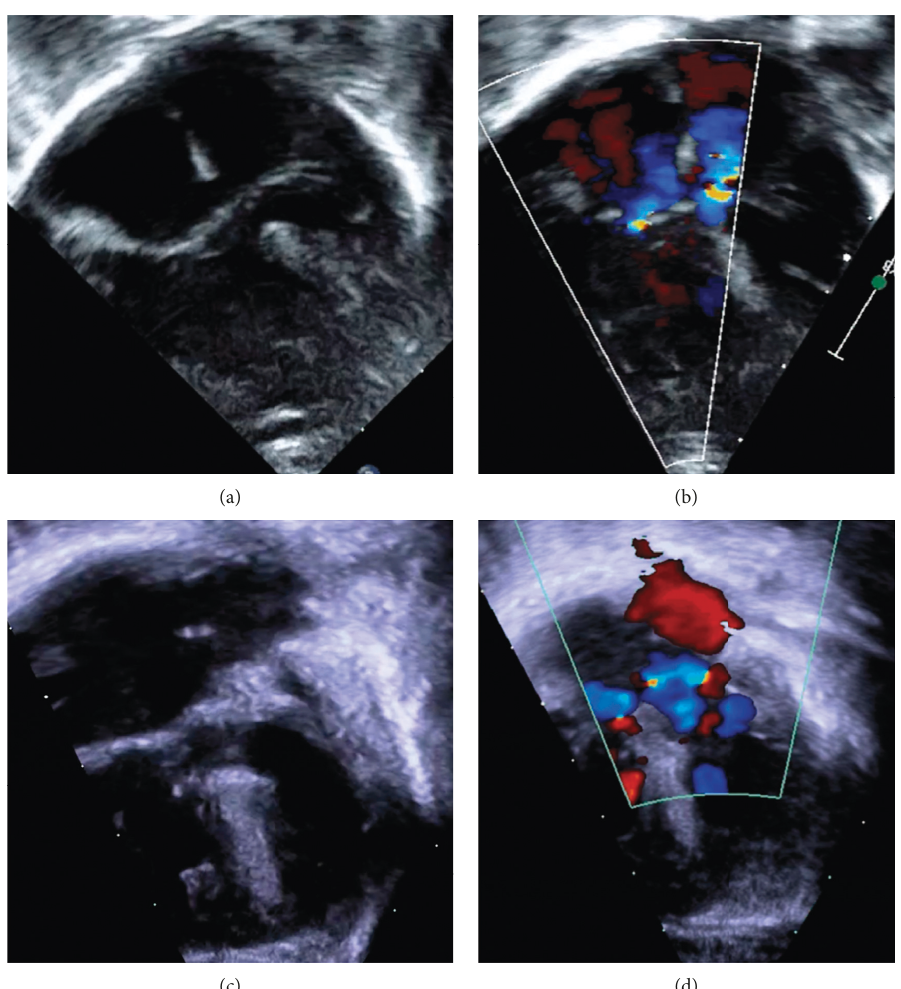
Figure 3: Postnatal four-chamber cardiac images. (a) Twin A 2D imaging showing a ventricular septal defect, primum atrial septal defect, and secundum atrial septal defect. (b) Twin A color Doppler showing left, central, and right atrioventricular valve regurgitation (blue flashes moving away from the transducer. (c) Twin B 2D imaging showing a ventricular septal defect, primum atrial septal defect, and secundum atrial septal defect. (d) Twin B color Doppler showing left and right atrioventricular valve regurgitation (blue flashes moving away from the